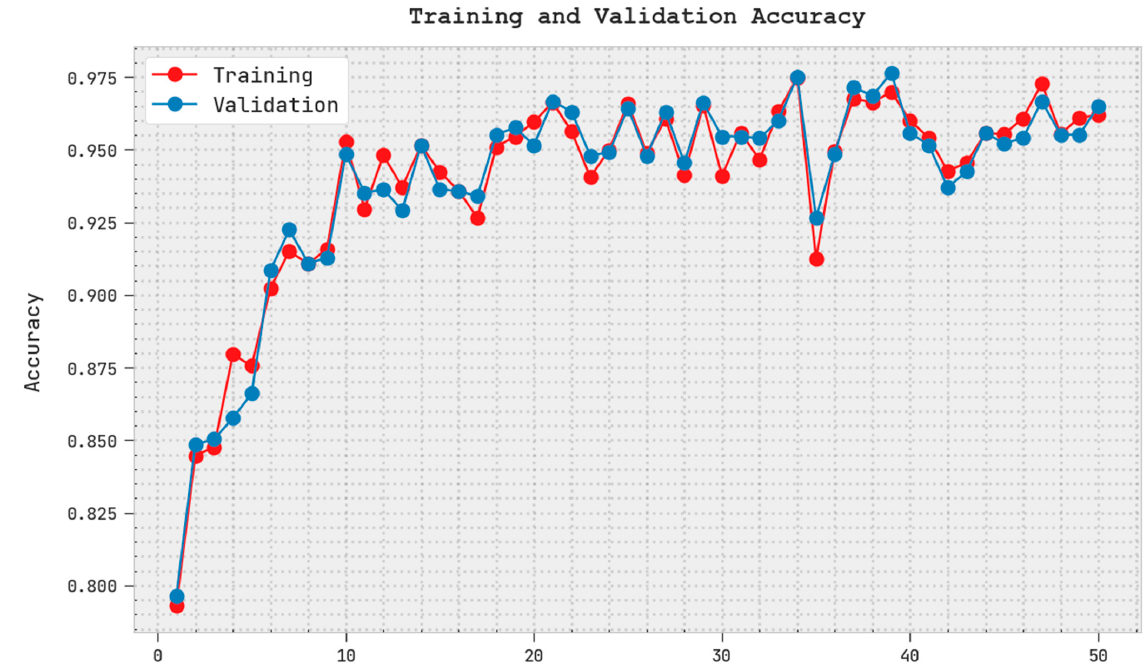
The training accuracy (TRA) and validation accuracy (VLA) gained by the PODCNN- LWID approach with the test dataset is shown in Figure 6. The experimental outcome implies that the PODCNN-LWID methodology attains maximal TRA and VLA values. The VLA is greater than the TRA.